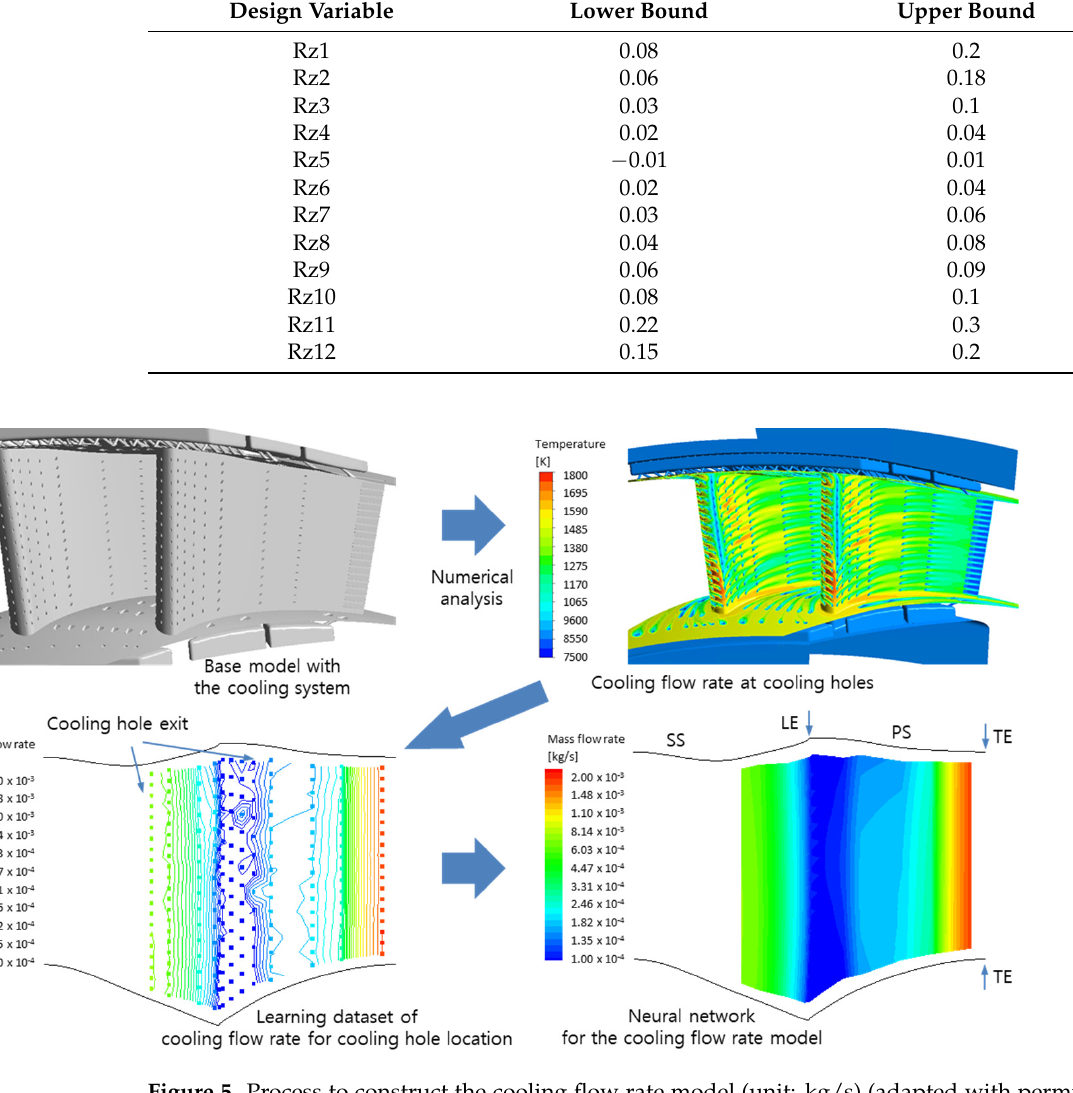
Table 1. Range of design variables (reprinted with permission from [16]; copyright 2021 Korean Society for Fluid Machinery). Design Variable Lower Bound Upper Bound